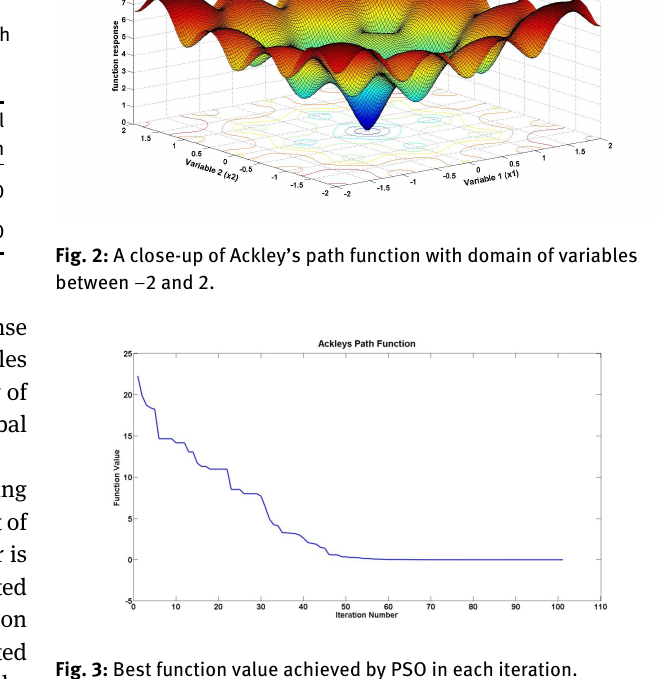
Fig. 3: Best function value achieved by PSO in each iteration.